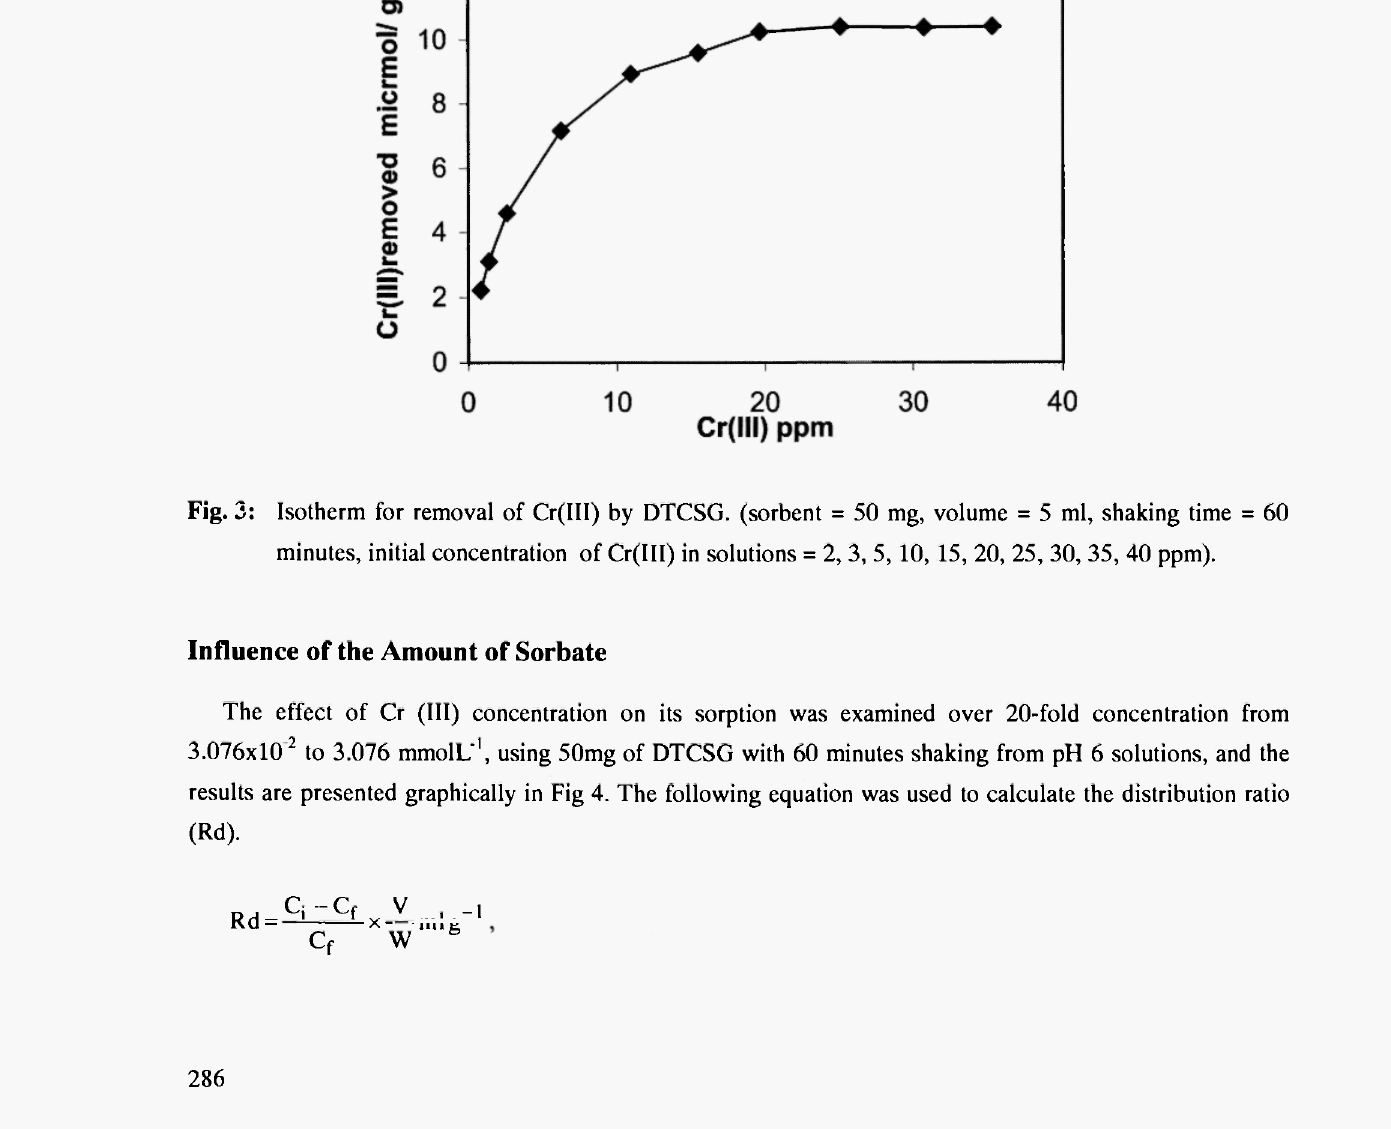
3.076x10 2 to 3.076 mmolL" 1 , using 50mg of DTCSG with 60 minutes shaking from pH 6 solutions, and